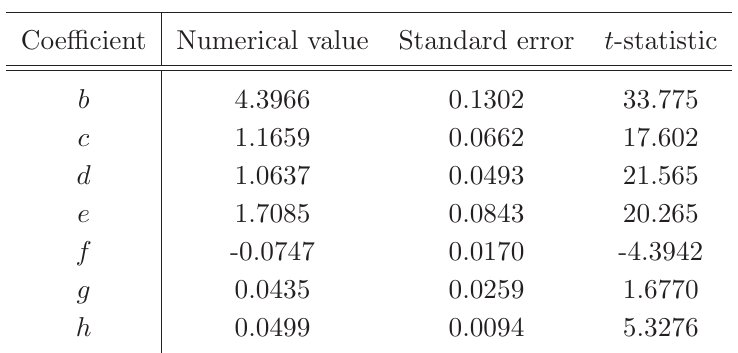
Table 2 Numerical values of coefficients estimated by MLR, standard errors and t −